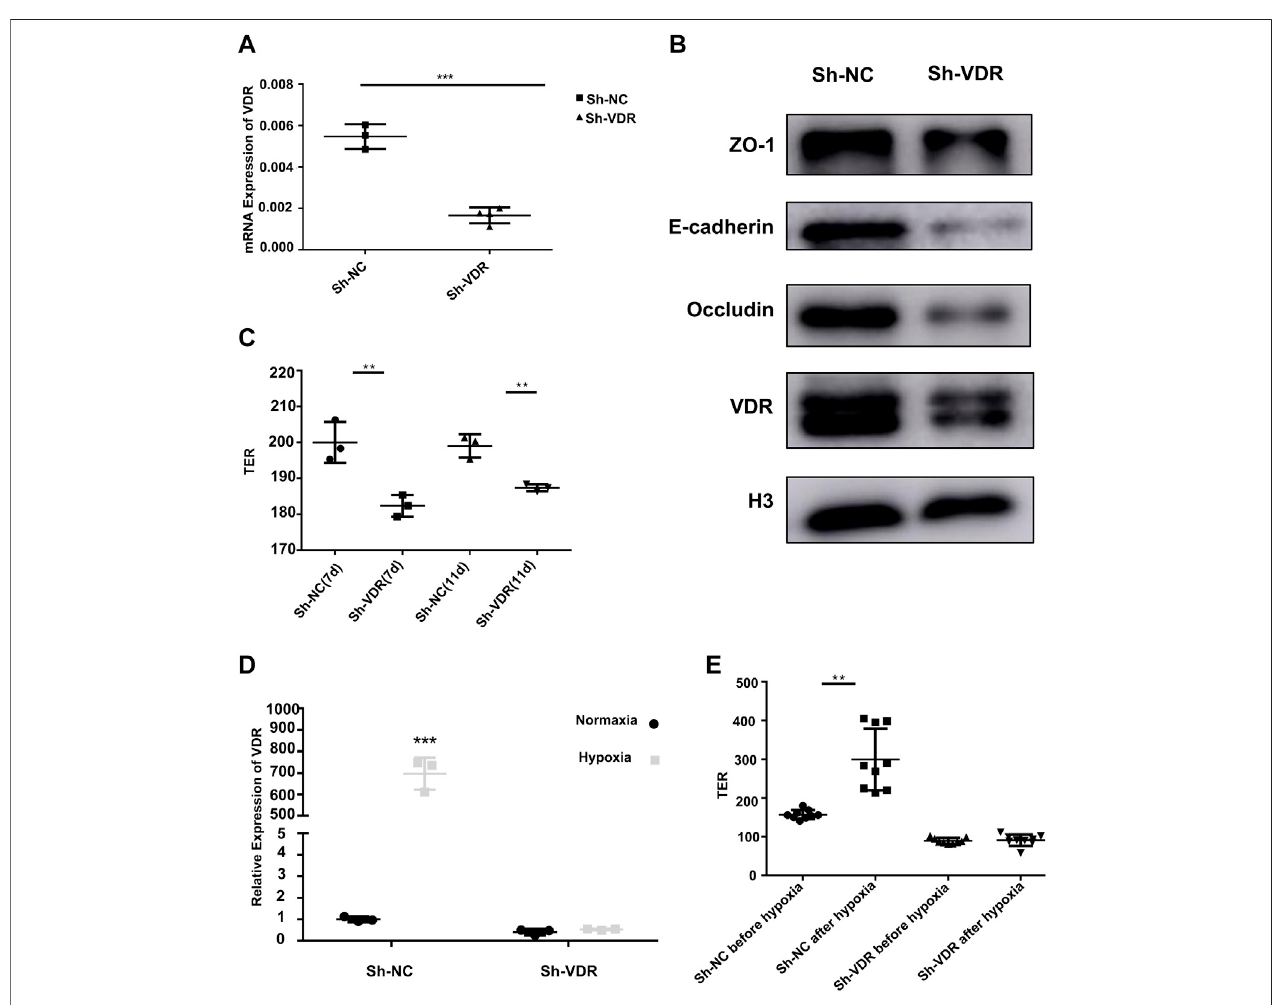
FIGURE4| VDRprotectingmucosalbarrierproteinandbarrierfunction invitro (A) :VDRmRNAexpressionbyRT-PCRinDLD-1sh-VDRcellsandtheircontrolsh-NCcells (*** P < 0.001). (B) : The expression of the mucosal barrier proteins ZO-1, E-cadherin, occludin, and VDR by Western blotting in DLD-1 sh-VDR cells. (C) : TER values of DLD-1 sh-NC and sh-VDR cells after continuous culture for 7 days and 11 days ( n = 3;** P < 0.01). (D) : VDR mRNA expression in sh-NC and sh-VDR cells under 1% O 2 for 48 h. (*** P < 0.001). (E) : The TER value of sh-VDR and sh-NC cells before and after hypoxic treatment (** P < 0.01). The experiments were repeated at least three times.